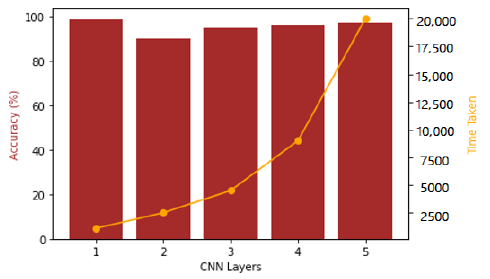
Figure 10. Accuracy associated with varied number of CNN